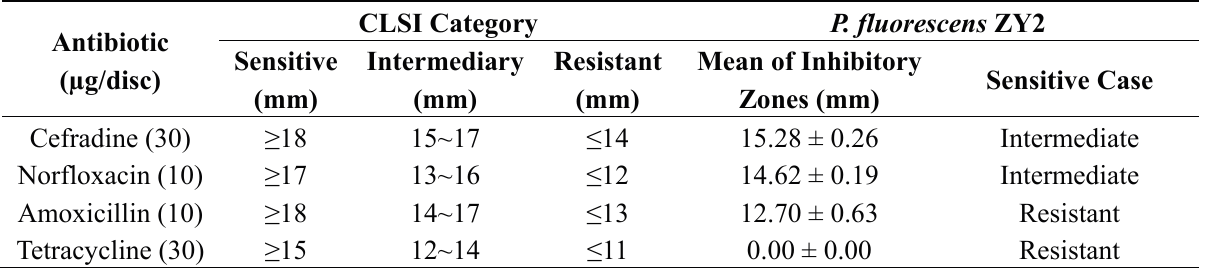
Table 1. Susceptibility of P. fluorescens ZY2 to four kinds of